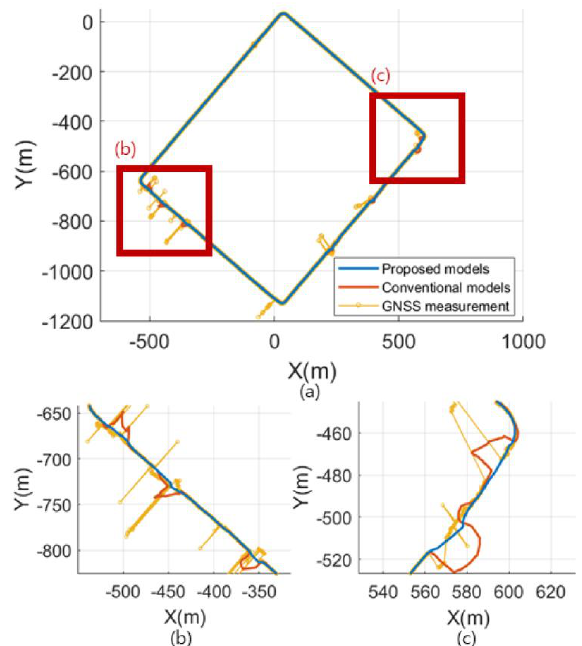
Figure 10. Comparison of the Extended Kalman filter (EKF) localization results of the proposed and conventional methods .